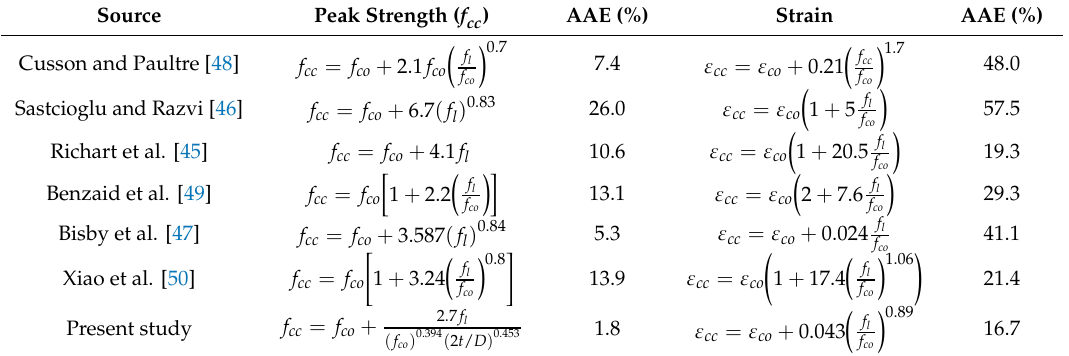
Table 9. Models used for calculation of f cc and ε cc and their average absolute error (AAE)